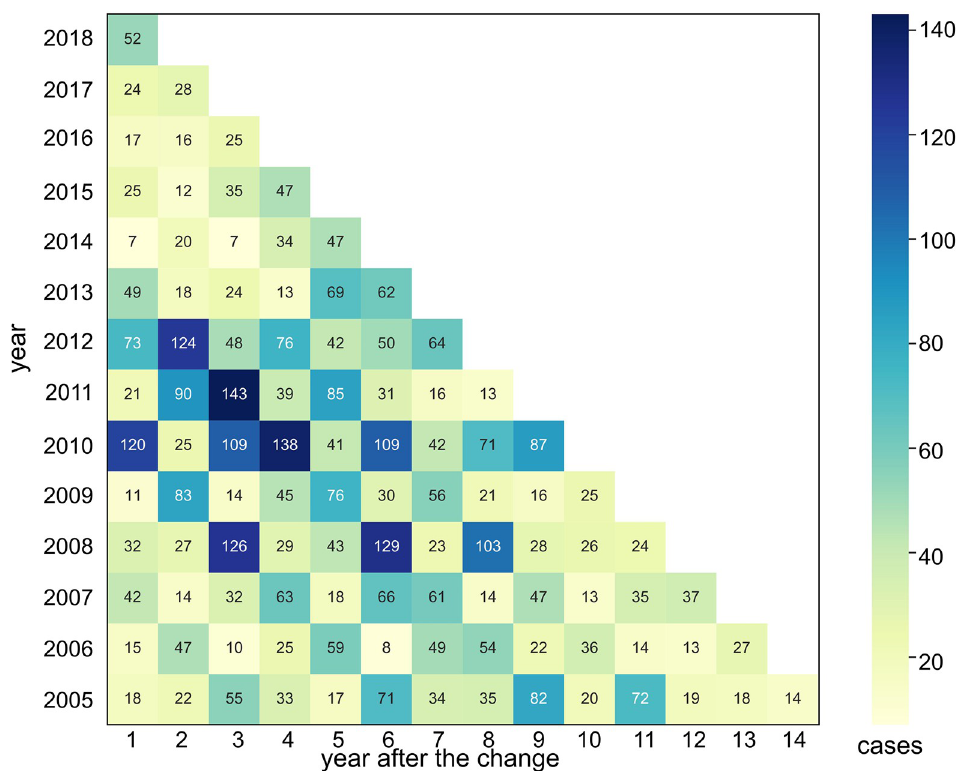
Fig 3. Statistical calculation of HFRS cases within the changed urbanization area from 2005 to 2018 for Xi’an.